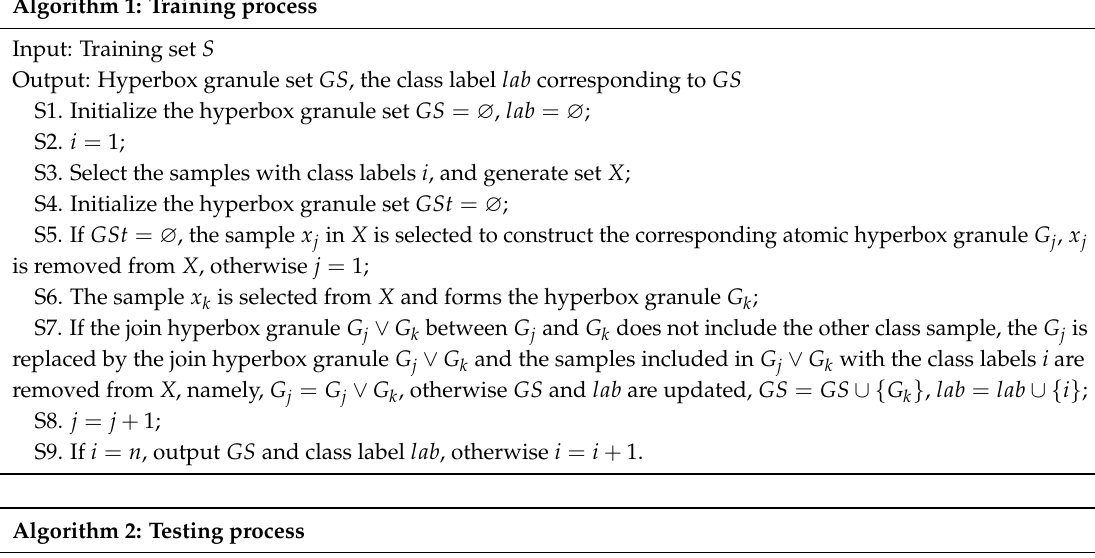
Algorithm 1: Training process